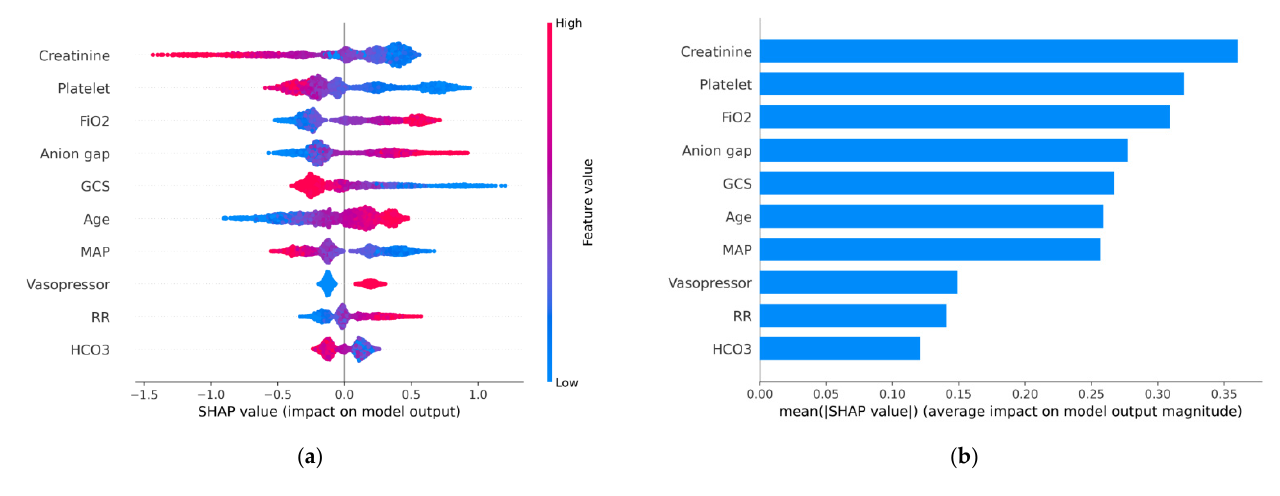
Figure 6. ( a ) Top 10 important features of the XGBoost model by SHAP value. The X-axis shows the distribution of the SHAP value, which reveals how much it impacts the outcome. The Y-axis is the feature value. The color represents the positive or negative contribution to outcome (red prone to death, blue prone to survival). ( b ) Ranks of the predictors by the mean absolute value of the SHAP values.